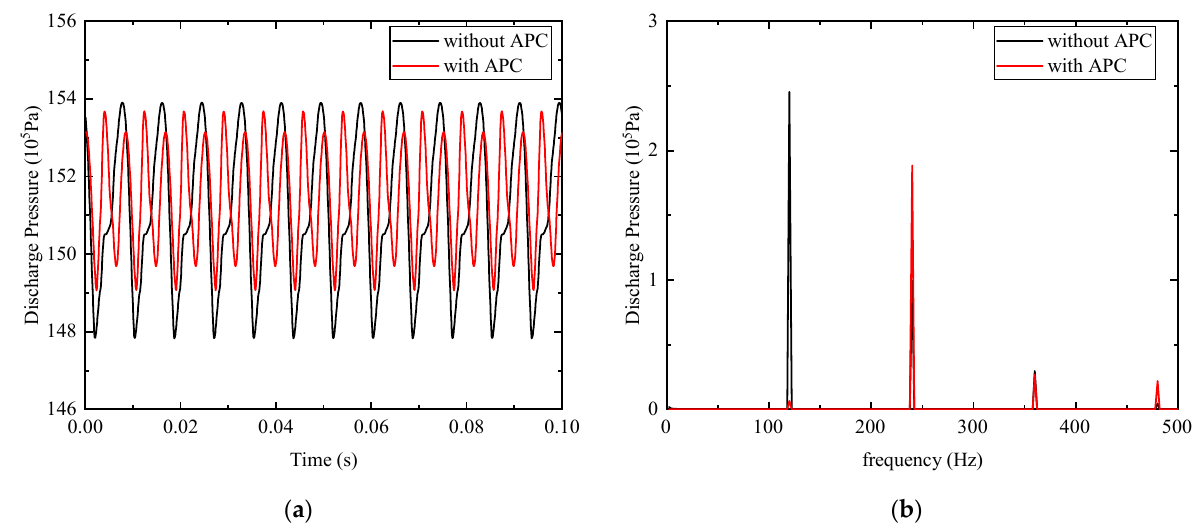
Figure 7. Comparisons of the discharge pressure with and without APC for the first-order frequency component: ( a ) time-domain discharge pressure; ( b ) FFT of pressure ripple.